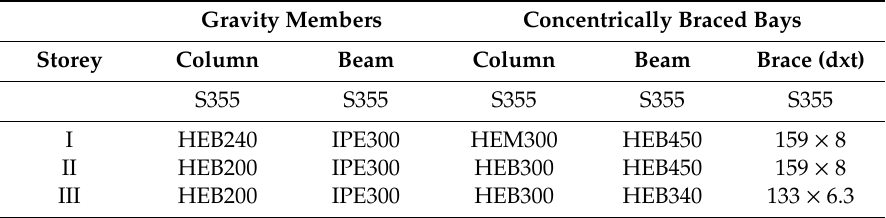
Table 1. Structural members for 3-Story chevron concentrically braced frame (CCBF).